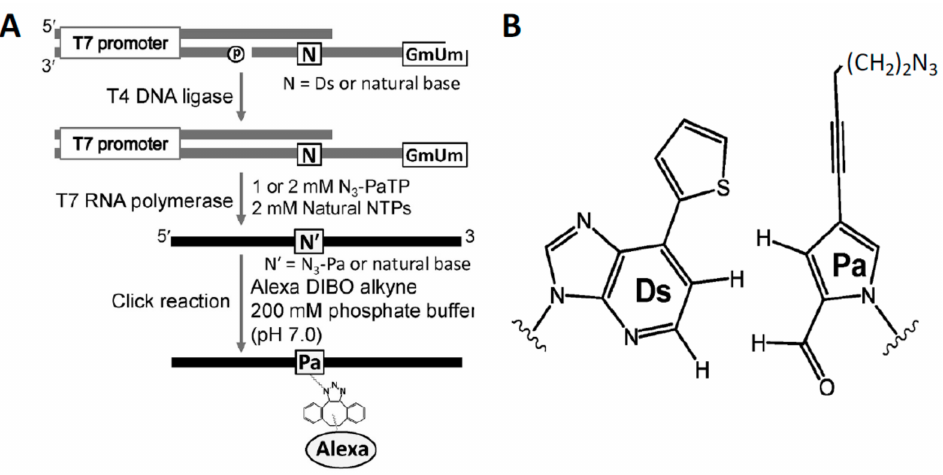
Figure 9. ( A ). The scheme for site-specific incorporation of the unnatural base pair X(Pa)-Y(Ds) into first DNA and then RNA. ( B ). An azide derivative of Pa was used to site-specifically incorporate an Alexa dibenzocyclooctyne fluorophor into several different RNAs by click chemistry. Adapted with permission from reference